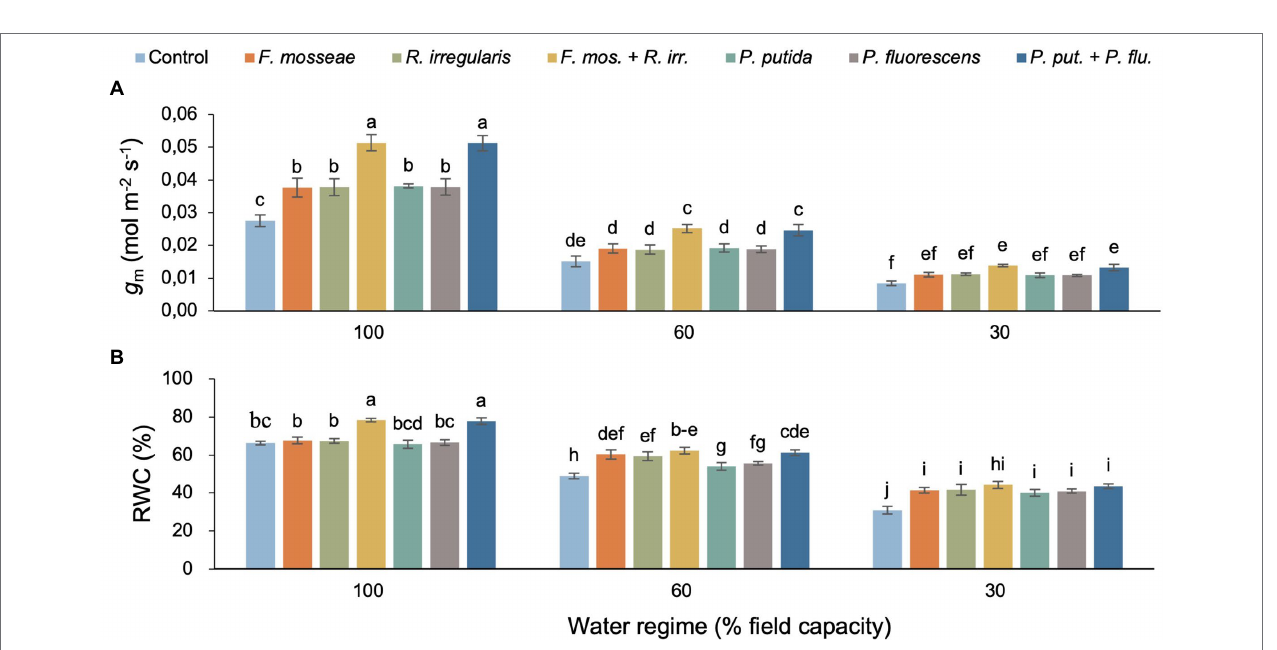
and PGPR inoculation significantly promoted leaf RWC in well-irrigated seedlings while single inoculations had no